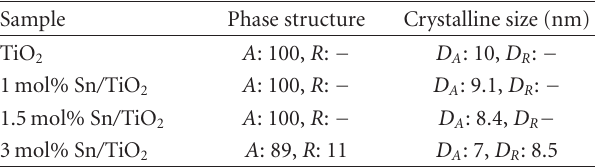
Table 2: Phase content and crystallite size of prepared nanoparti- cles.